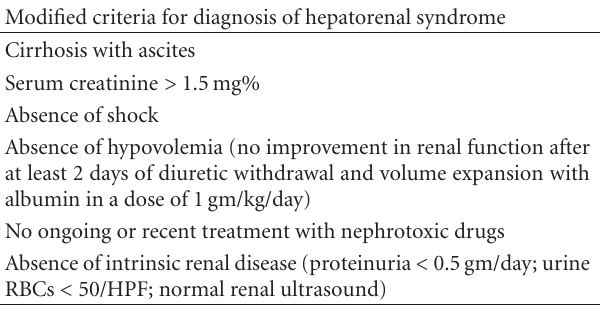
Table 2: Therapeutic modalities used in HRS and their e ff ect on renal function and